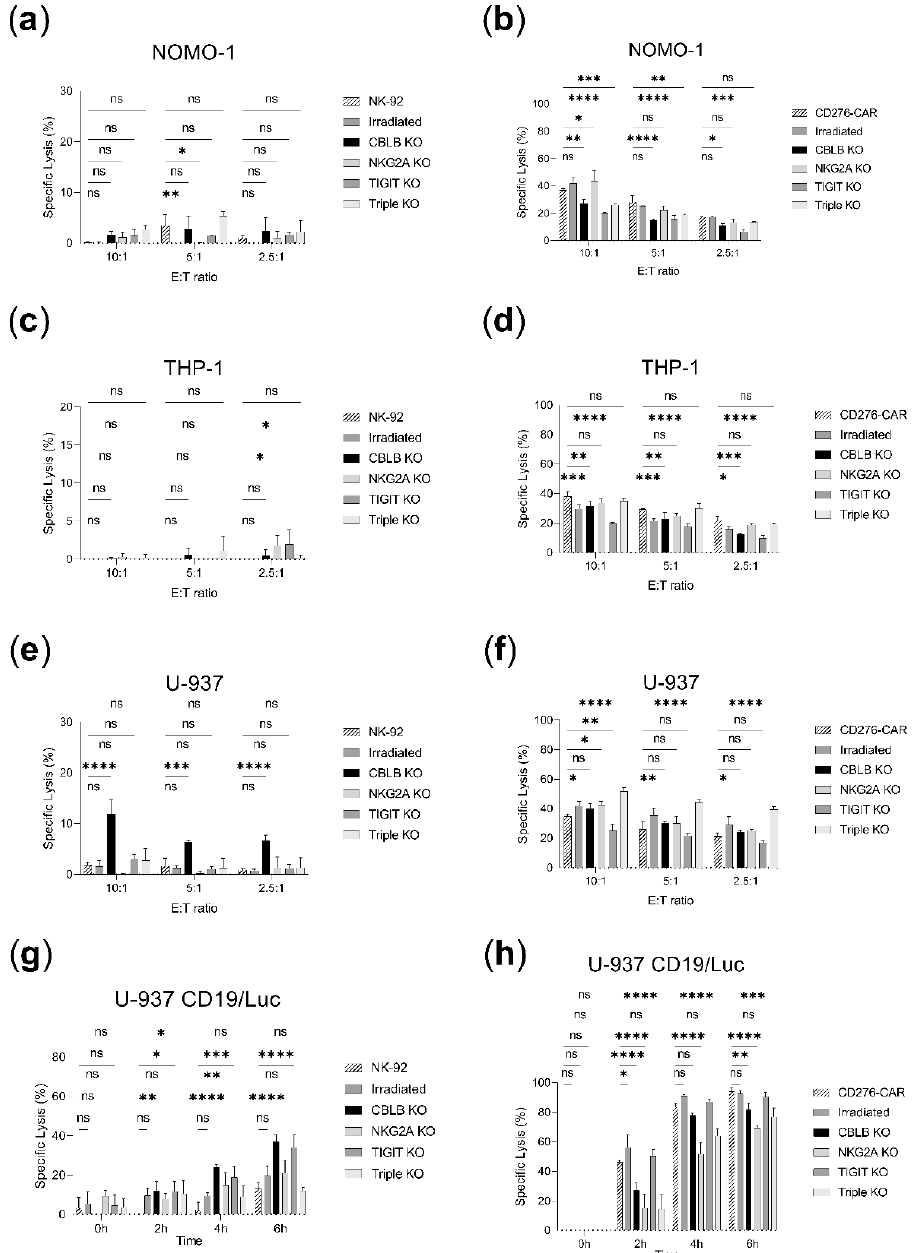
Figure 6. Cytotoxicity assays in AML cell lines comparing parental NK-92 and CD276-CAR-NK-92 vs. irradiated, CBLB, NKG2A, TIGIT or triple knock-out cells. Specific lysis is shown as mean ± SD ( n = 3). Calcein assays were incubated for 2 h and several effector-to-target (E:T) ratios were em- ployed: 10:1, 5:1, 2.5:1. Luciferase assays were studied for a time span of 6 h at 5:1 E:T ratio. ( a ) NK- 92 cell lines vs. NOMO-1 calcein assay. ( b ) CD276-CAR-NK-92 cell lines vs. NOMO-1 calcein assay. ( c ) NK-92 cell lines vs. THP-1 calcein assay. ( d ) CD276-CAR-NK-92 cell lines vs. THP-1 calcein assay. ( e ) NK-92 cell lines vs. U-937 calcein assay. ( f ) CD276-CAR-NK-92 cell lines vs. U-937 calcein assay. ( g ) NK-92 cell lines vs. U-937 CD19tag/Luc luciferase assay. ( h ) CD276-CAR-NK-92 cell lines vs. U- 937 CD19tag/Luc luciferase assay. * p < 0.05; ** p < 0.01; *** p > 0.001; **** p < 0.0001; ns, non-significant ( p > 0.05).